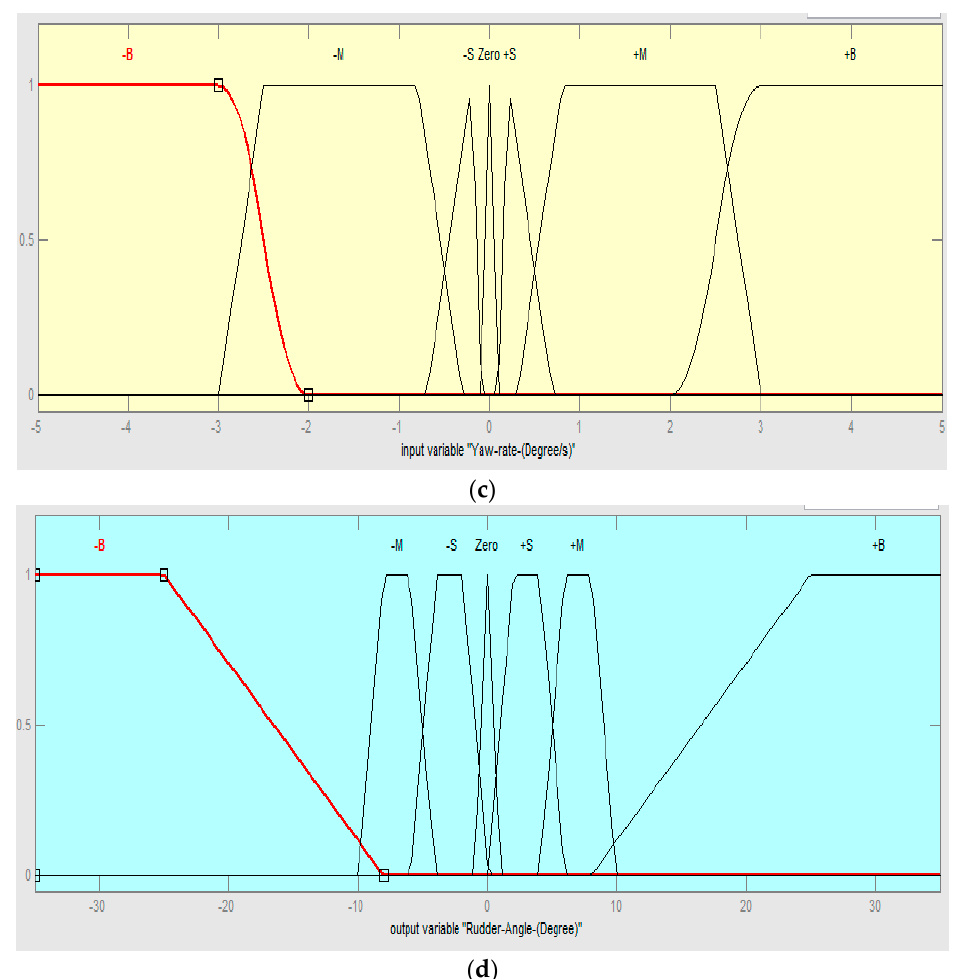
Figure 6. Membership functions of three inputs and one output of track-keeping controller: ( a ) Cross tracking error; ( b ) heading error; ( c ) yaw rate; ( d ) rudder angle.